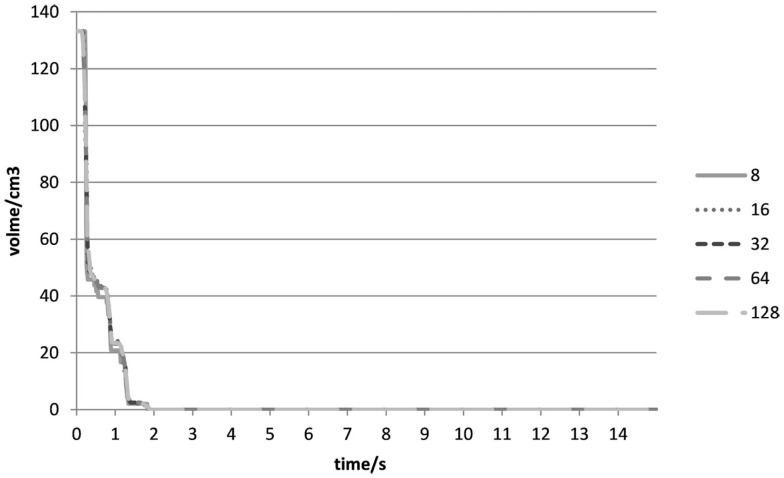
Type II volumetric errors (cm3) over time (s) for different voxel resolutions in Experiment 1.